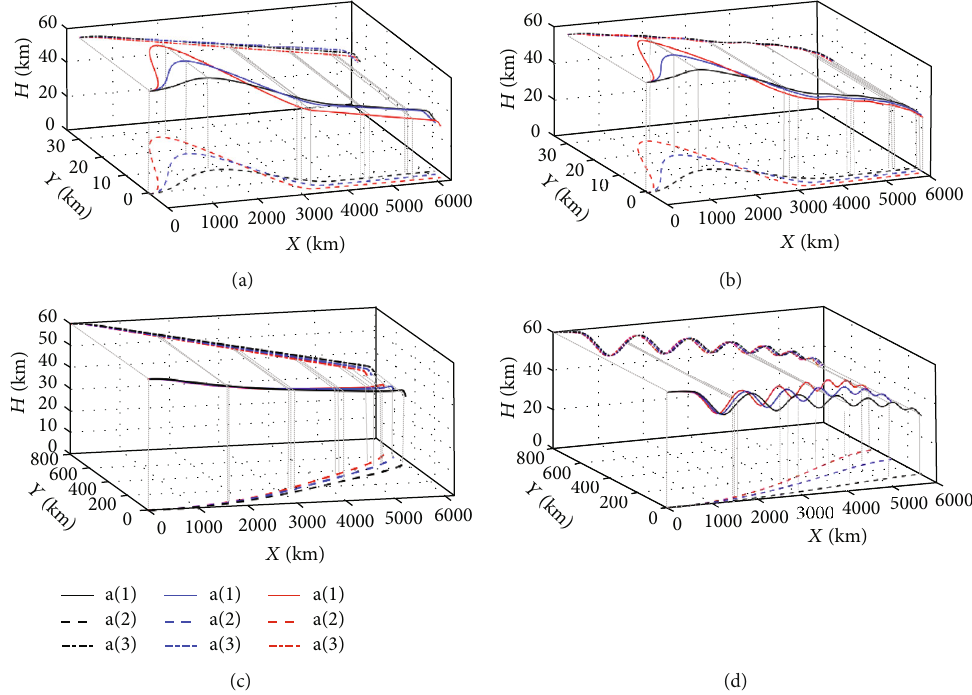
Figure 7: Example trajectory in di ff erent maneuver modes. (a) represents trajectories in weaving equilibrium glide. (b) represents trajectories in weaving skip glide. (c) represents trajectories in turning equilibrium glide. (d) represents trajectories in turning skip glide.